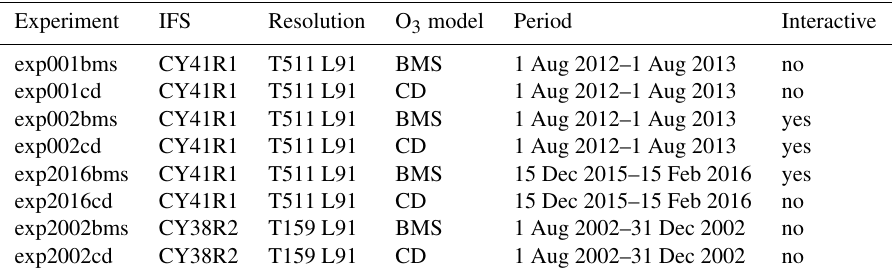
Table 1. Medium-range (10d forecasts) IFS model experiments using the default IFS Cariolle v2.9 ozone scheme (CD), or the new BMS ozone scheme (BMS). For each experiment information on model version, resolution, period covered and whether prognostic ozone was interactive with radiation is also